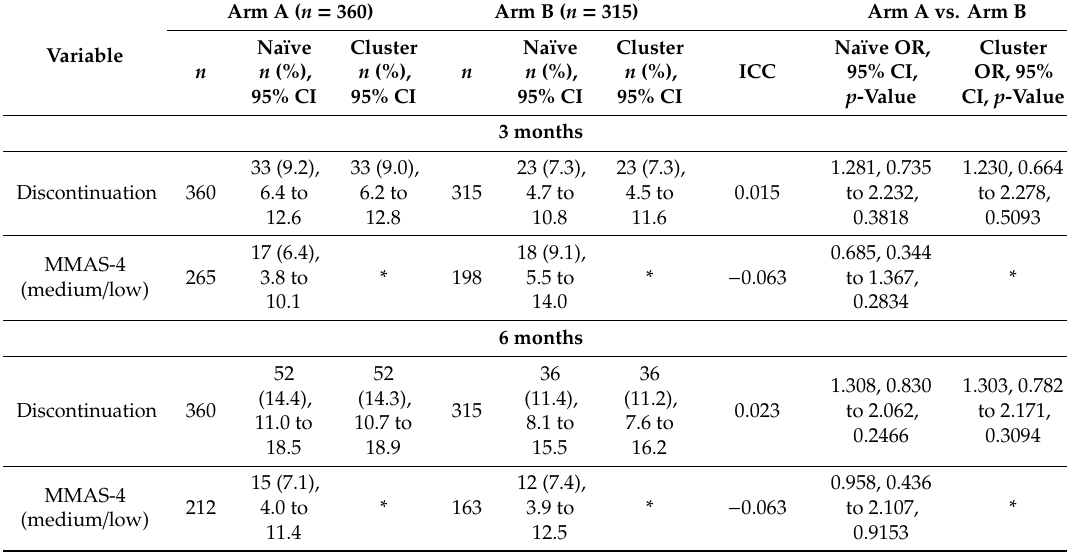
Table 3. Treatment discontinuation and medication adherence at 3 and 6